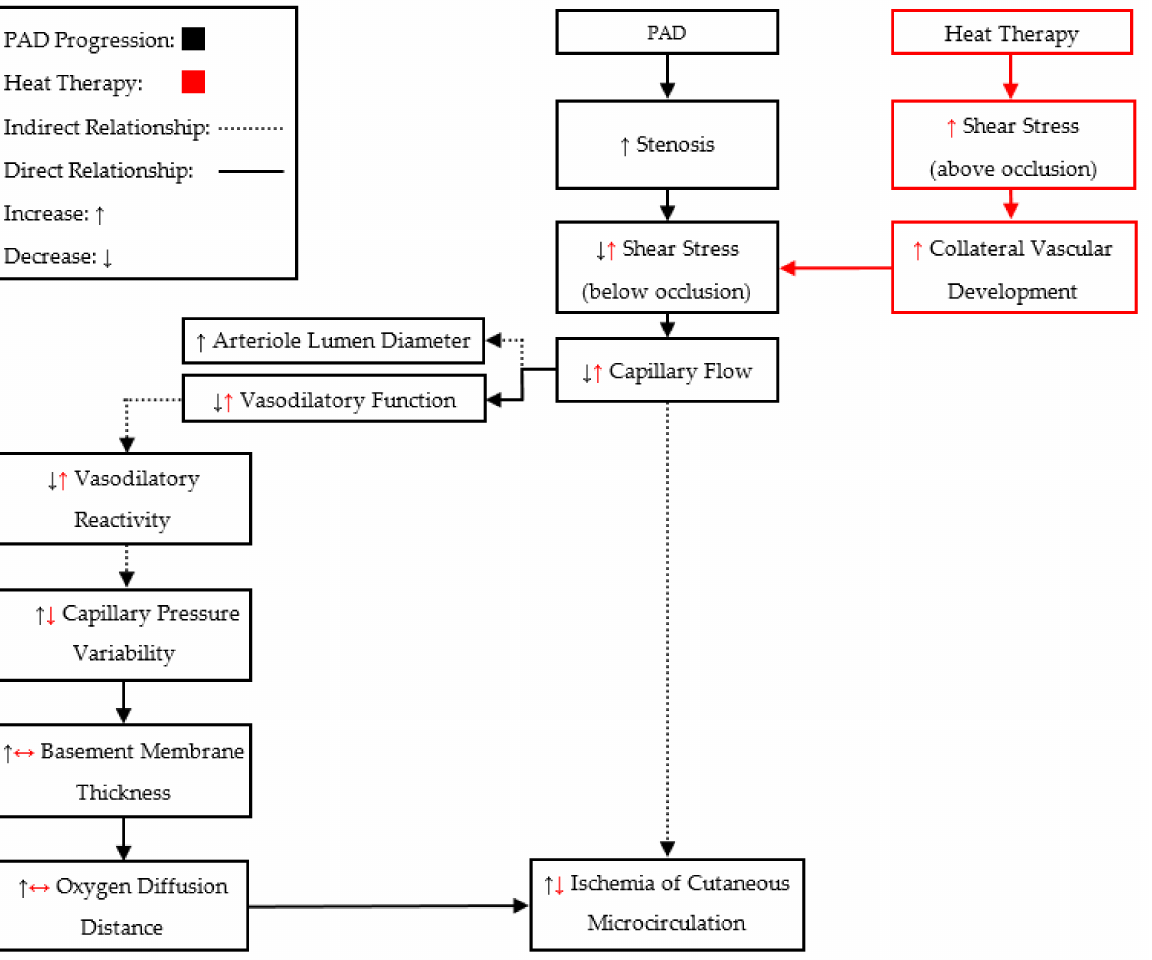
Figure 3. A proposed mechanism for how heat therapy may attenuate the progressive ischemia that is characteristic of peripheral artery disease (PAD). Heat therapy may generate beneficial arterial adaptations, leading to improved arterial function and reduced tissue